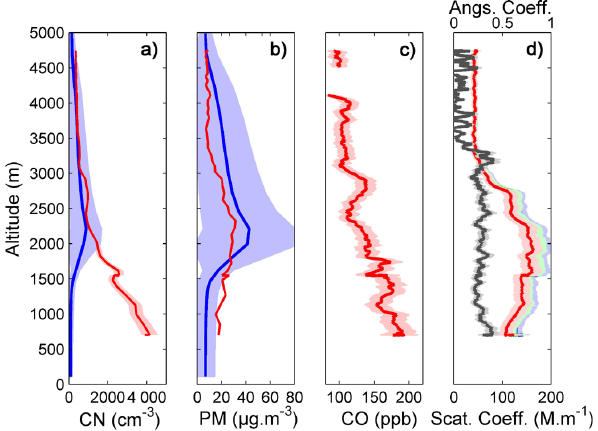
Fig. 5. Profiles of the particle number (a) and mass (b) con- centrations at 12.6 ◦ N and 2 ◦ E observed by the ATR-42 between 15:15UTC and 15:30UTC on 14 June 2006 (red lines) and simu- lated at 15:00UTC on 14 June 2006 (blue lines). The blue areas cor- respond to the spatial variability (1 ◦ around the ATR-42 sounding zone) of dust concentration for particles with diameter lower than 2.5µm. Profiles of the CO concentration (c) and the scattering co- efficient (d) at three wavelengths (450nm, 550nm, 700nm; respec- tively blue, green and red lines) observed by the ATR-42 are also plotted. On (d) , the black line represents the calculated Angstrom coefficient and the coloured areas correspond to the instrument’s internal variability.